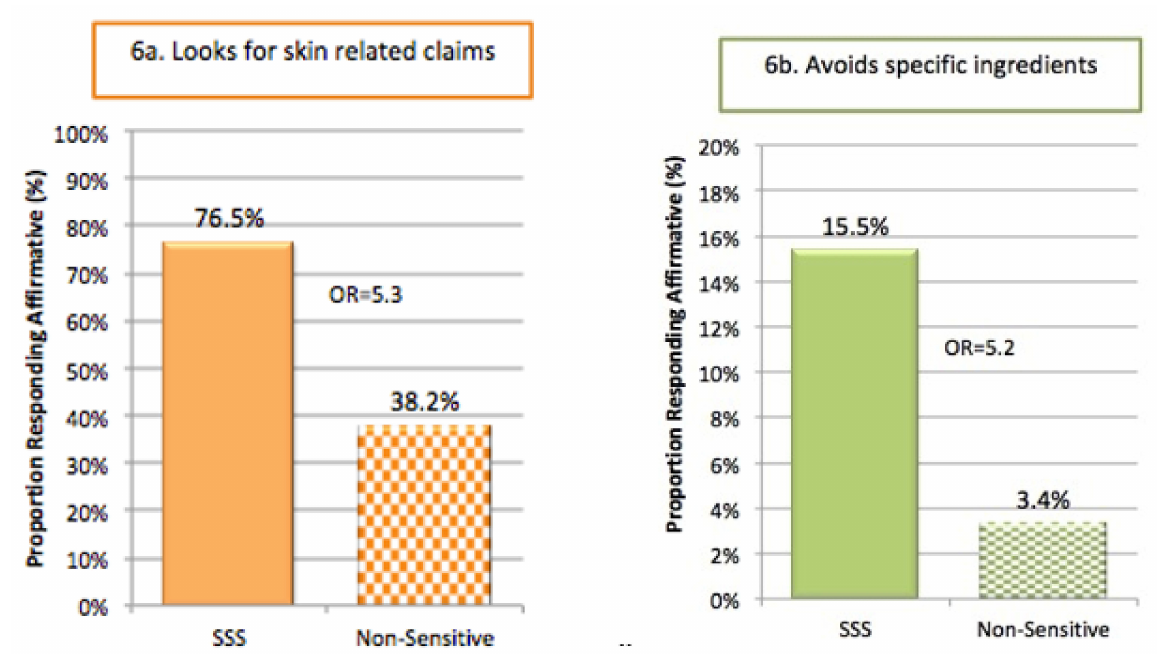
Figure 6. Influence of SSS on shopping practices. Responders in the Cincinnati study were asked about specific shopping practices. ( a ) Compared to the non-SS group, the SS subjects were far more likely to look for skin-related claims on products (such as, “safe for sensitive skin” and “hypoallergenic”) (odds ratio (OR) = 5.3). ( b ) The SS group was more likely to avoid specific ingredients when shopping. (odds ratio (OR) =